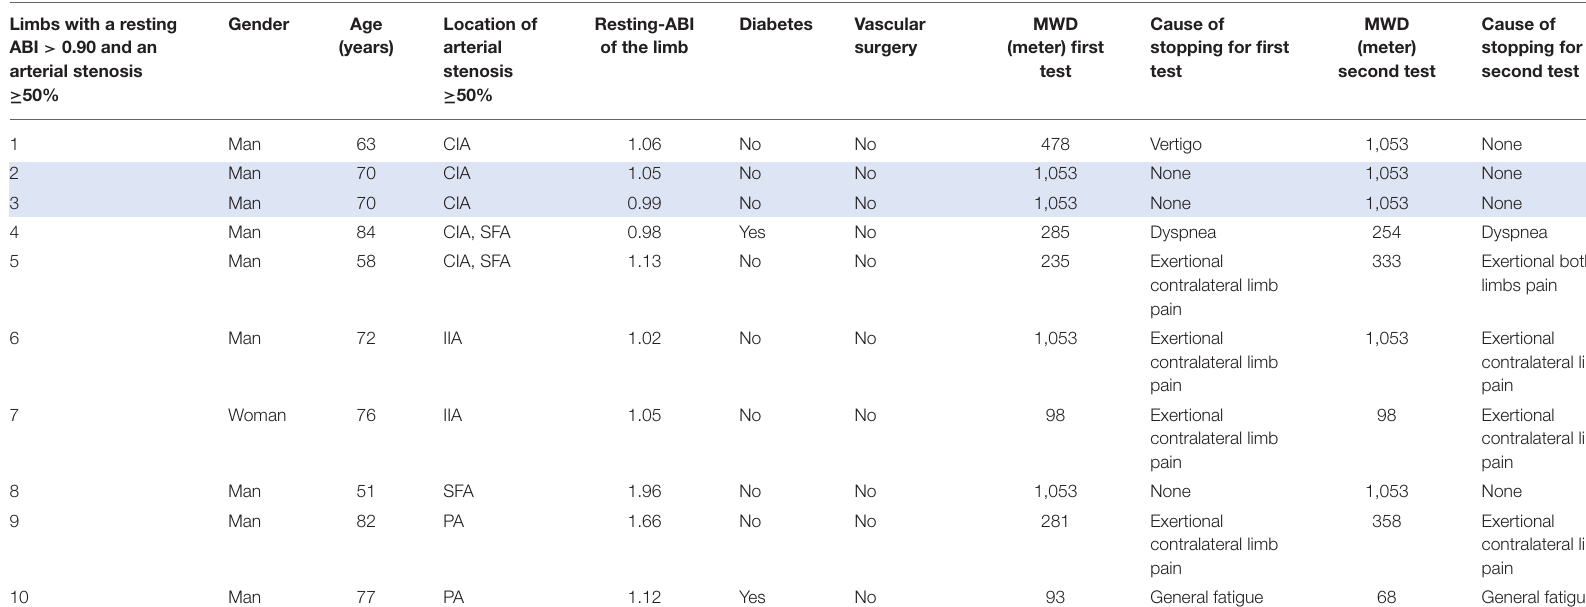
General fatigue 68 General